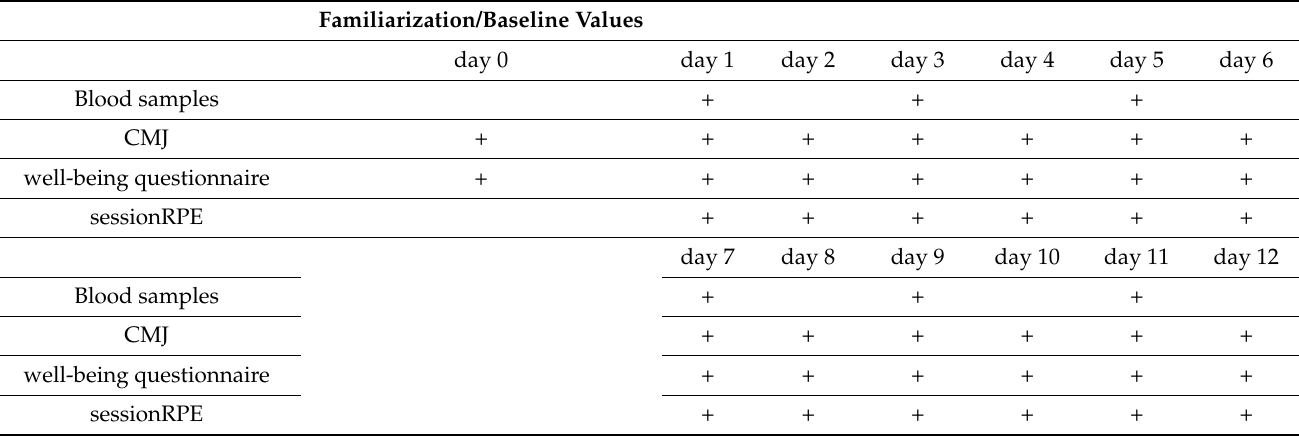
Table 1. Daily schedule of tests performed during the 12 days of the experiment. Familiarization/Baseline